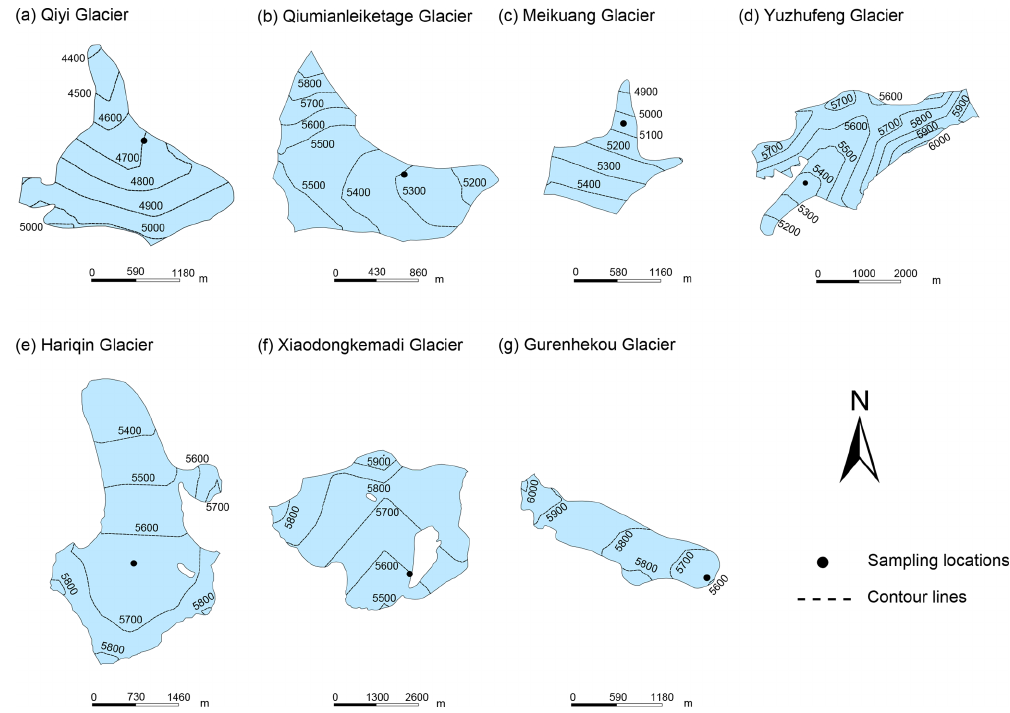
Figure 1. Geographical locations of (a) Qiyi Glacier (39.24 ◦ N, 97.76 ◦ E), (b) Qiumianleiketage Glacier (36.70 ◦ N, 90.73 ◦ E), (c) Meikuang Glacier (35.67 ◦ N, 94.19 ◦ E), (d) Yuzhufeng Glacier (35.65 ◦ N, 94.23 ◦ E), (e) Hariqin Glacier (33.14 ◦ N, 92.09 ◦ E), (f) Xiaodongkemadi Glacier (33.07 ◦ N, 92.07 ◦ E), and (g) Gurenhekou Glacier (30.19 ◦ N, 90.46 ◦ E). The black dots indicate sampling